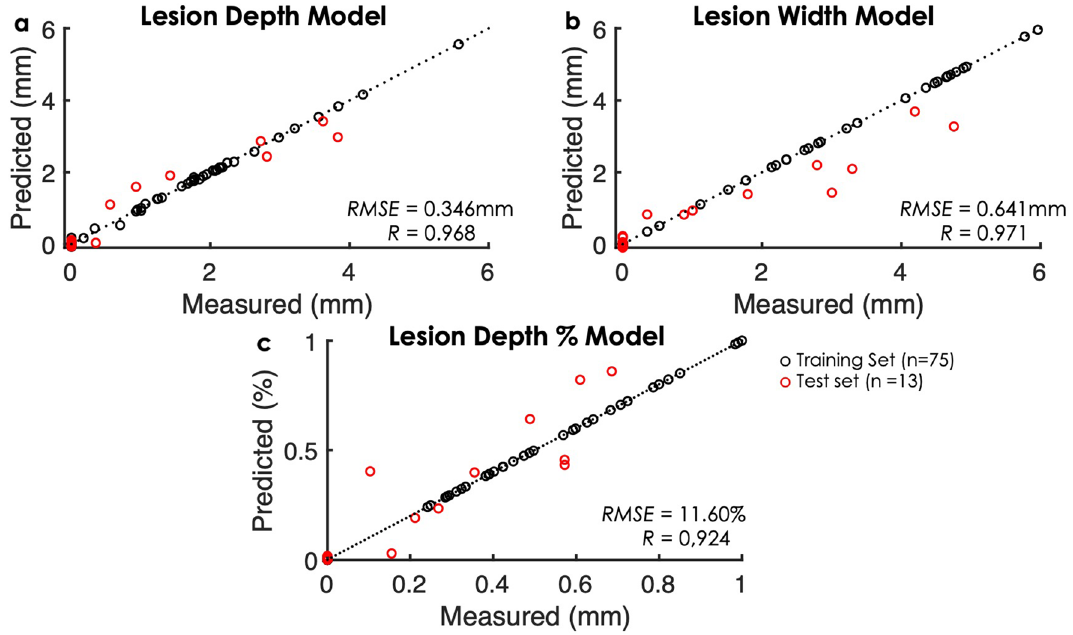
Figure 4. Comparison between model predictions and measured lesion depth ( a ), width ( b ), and depth percentage ( c ) across all samples. Black circles correspond to the evaluations across the full training set which comprises the validation set (n = 75); red circles correspond to test set samples (n =